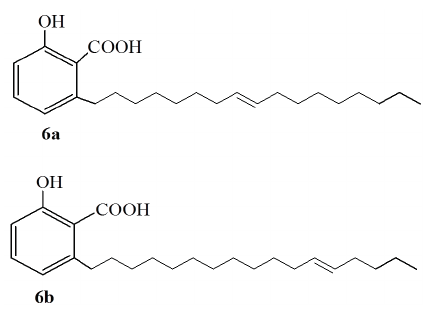
Figure 3. Natural anacardic acid 6a isolated from ginkobiloba and 6b isolated from geraniums.